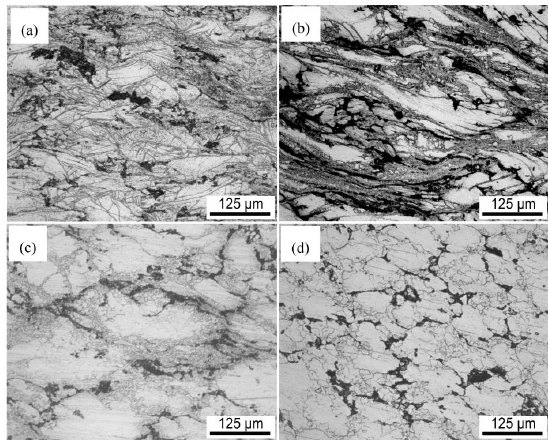
Figure 1. Optical microscopy (OM) images of nano-SiCp/AZ91 composite after single-pass forging at different temperatures: ( a ) 250 °C; ( b ) 300 °C; ( c ) 350 °C; ( d ) 400 °C.